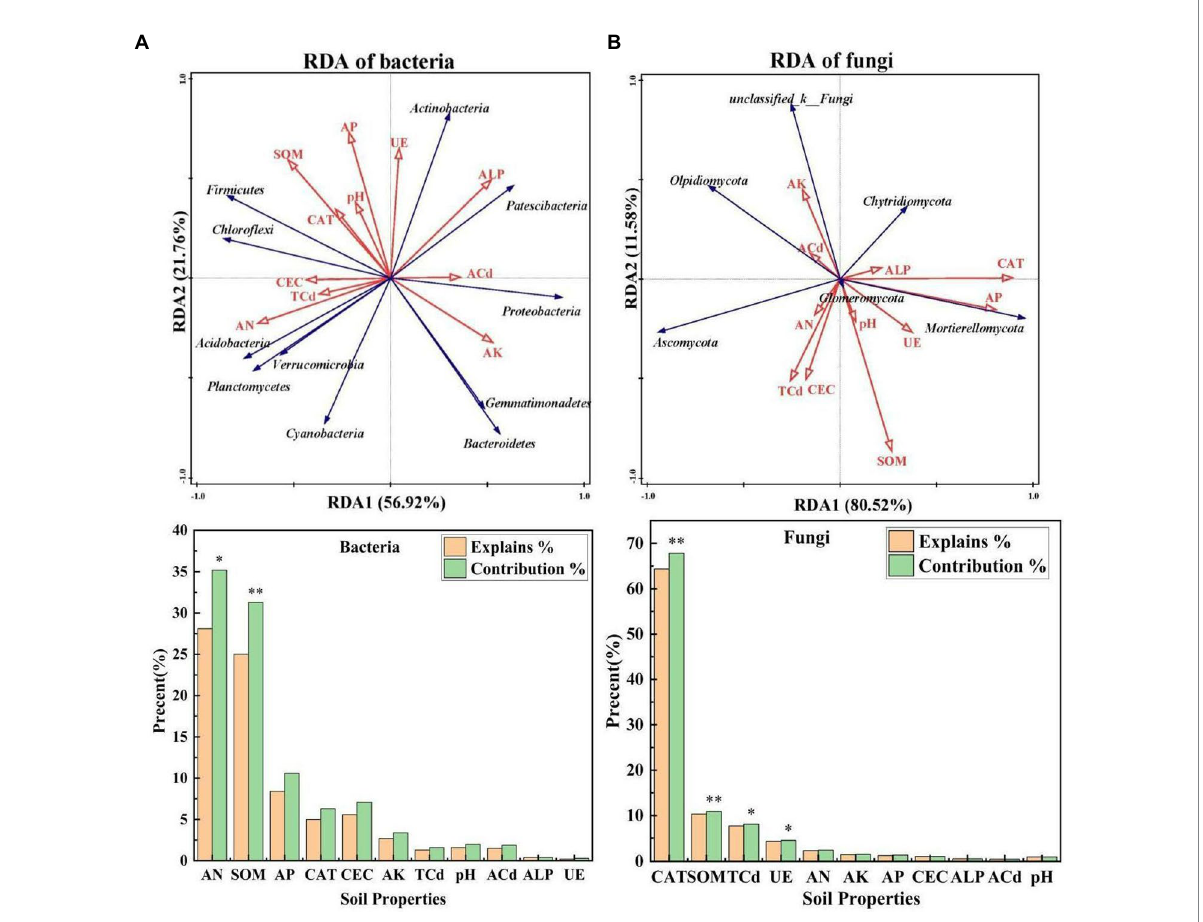
FIGURE 3 (A,B) Redundancy analysis of the dominant bacteria, dominant fungi, and environmental factors under different treatments [ S . nigrum (CK), Bacillus megaterium (BM) along with citric acid (BM + CA), Glomus mosseae (BM + GM), and Piriformospora indica (BM + PI)]. The blue arrows indicate microbial communities, and the red arrows indicate soil properties. ALP, CAT, and UE indicate alkaline phosphatase activity, catalase activity, and urease activity, respectively; AN, AP, and AK indicate available nitrogen, available phosphorus, and available potassium, respectively; SOM and CEC indicate soil organic matter and cation exchange capacity, respectively; and TCd and ACd indicate total cadmium and available cadmium, respectively. Values marked with * indicate significant differences at p < 0.05, and values marked with ** indicate significant differences at p <